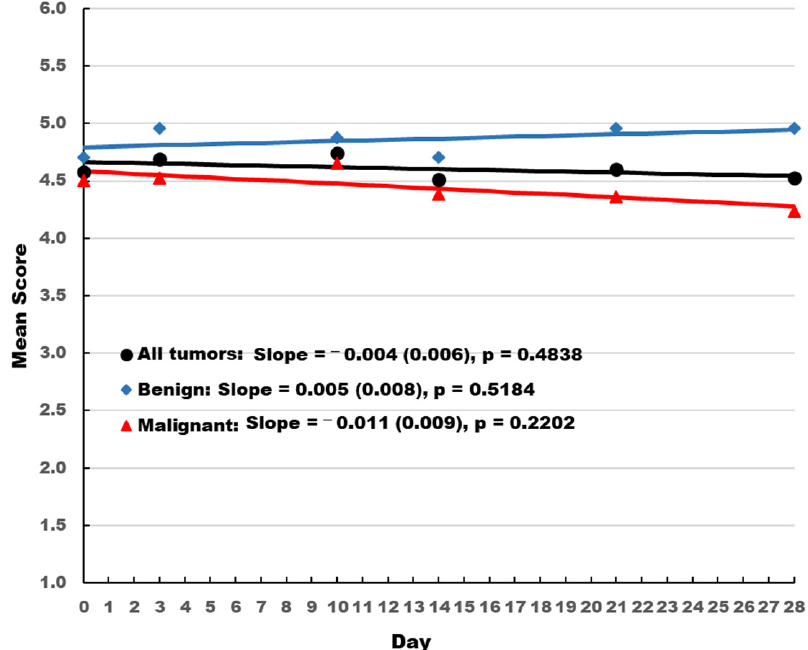
Figure 1. Owner-reported stool quality score. Slope and standard error is presented. The p values indicate whether the slope is significantly different from 0.